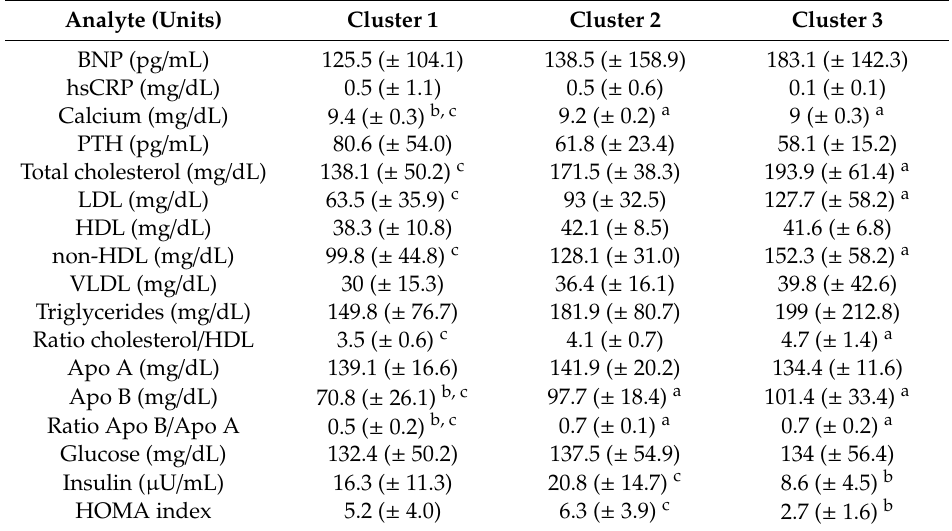
Table 3. Biochemical and metabolic parameters in the three clusters of patients with heart